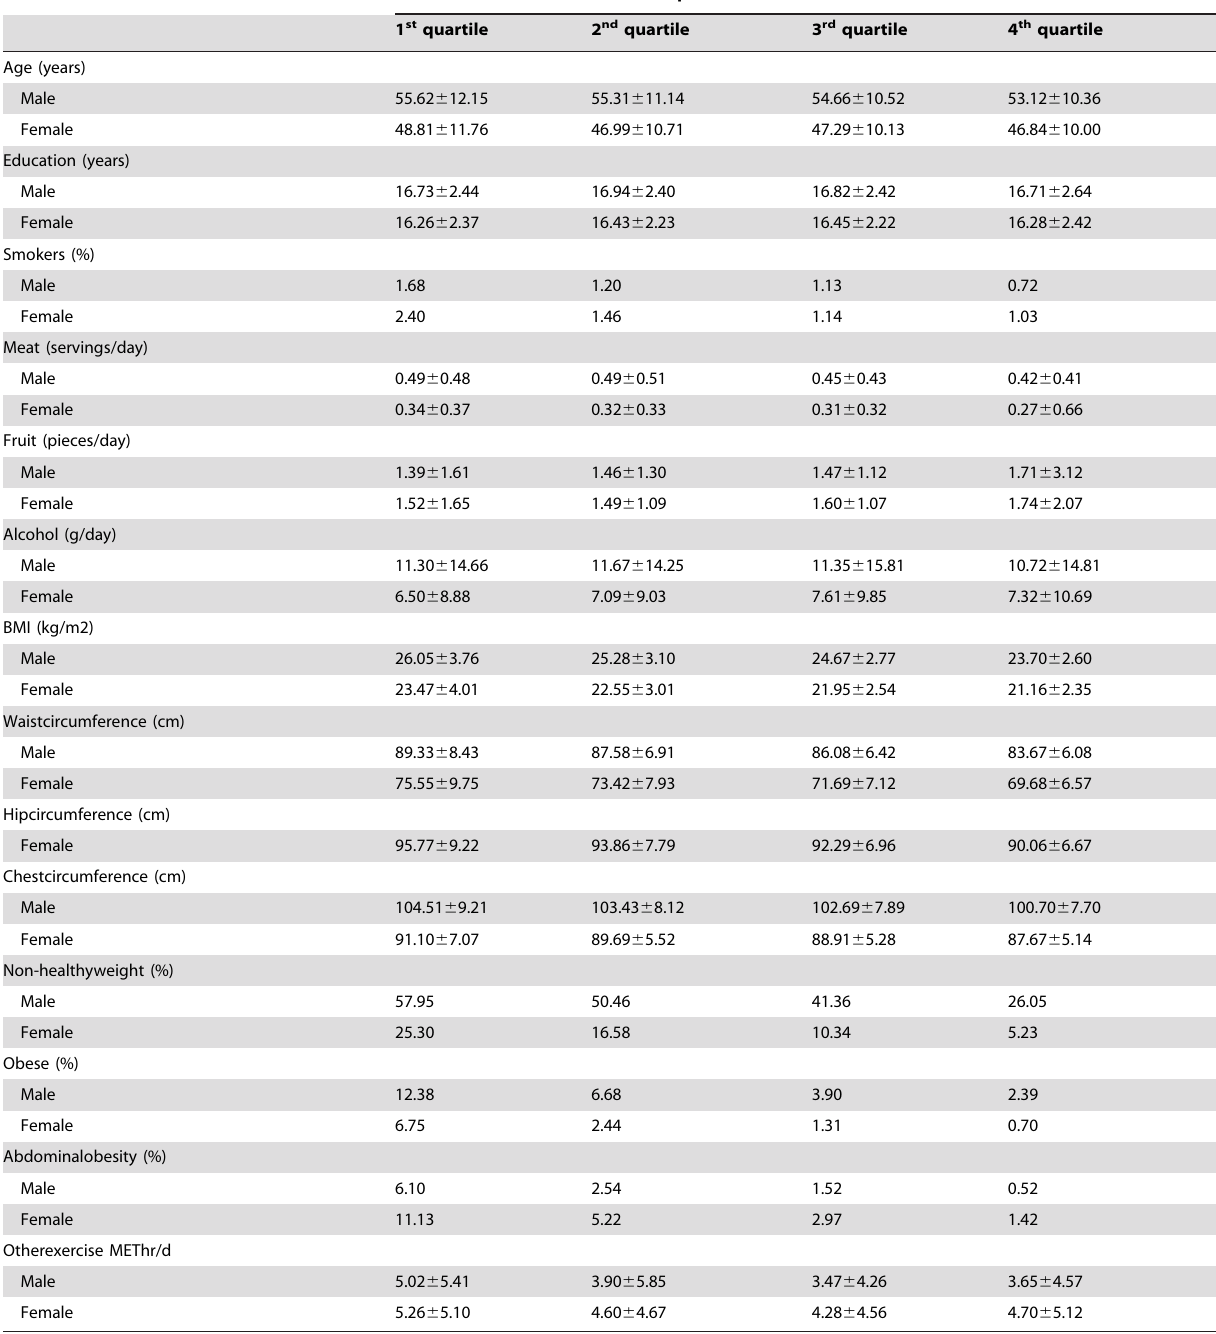
Quartiles of METhr/d from self-reported distance